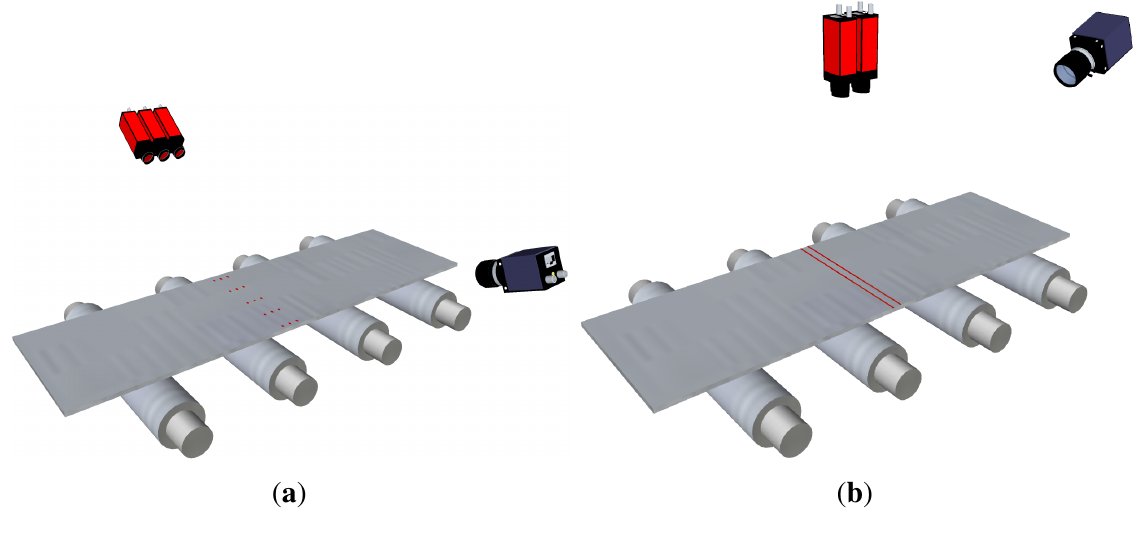
Figure 10. Flatness sensors based on active optical triangulation using multiple laser patterns: ( a ) multi-spot pattern; ( b ) multi-stripe or multi-line